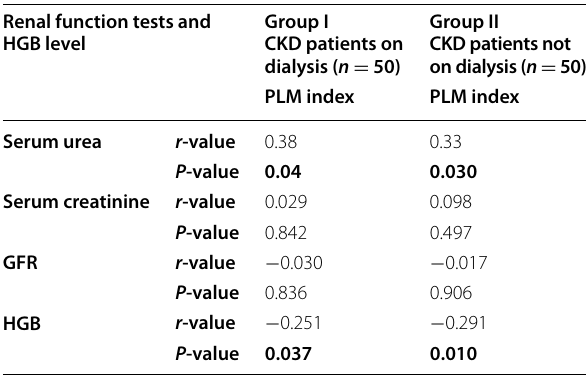
Table 3 Periodic leg movements among both groups of CKD patients